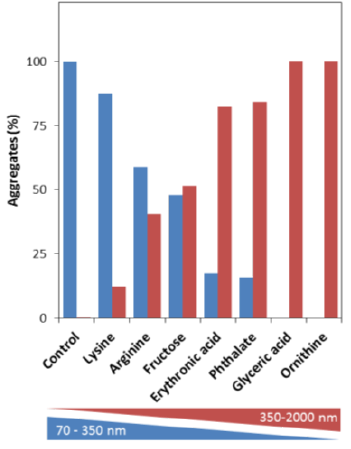
Figure 4. Metabolites boost the formation of larger apoSOD1 aggregates. Nanoparticle Tracking Analysis (NTA) of the distribution of total apoSOD1 aggregates generated from 50 μM apoSOD1, alone and in the presence of 200 μM of each metabolite after incubation at pH 7.4 under agitation at 37 °C for 200 h (metabolite:protein = 4). Blue bars correspond to the distribution of small aggregates (70–350 nm) and red bars correspond to larger aggregates (350–2000 nm). See experimental section for further